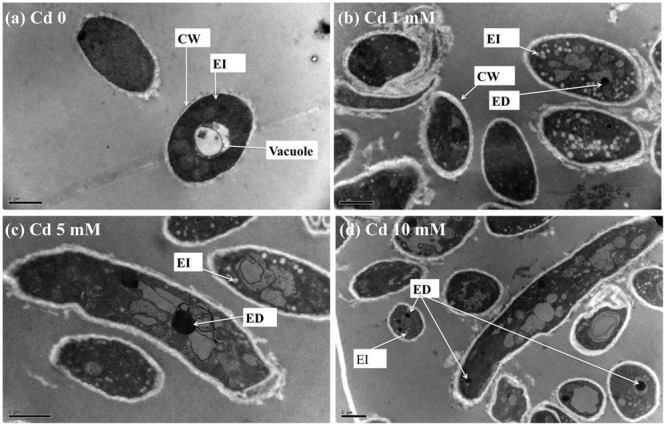
TEM micrographs of P. chrysogenum XJ-1 exposed to various Cd concentrations at (a) 0, (b) 1 mM, (c) 5 mM, and (d) 10 mM for 120 h. (CW, cell wall; EI, electron-transparent bodies; ED, electron-dense bodies; Bars represent 1 μm).